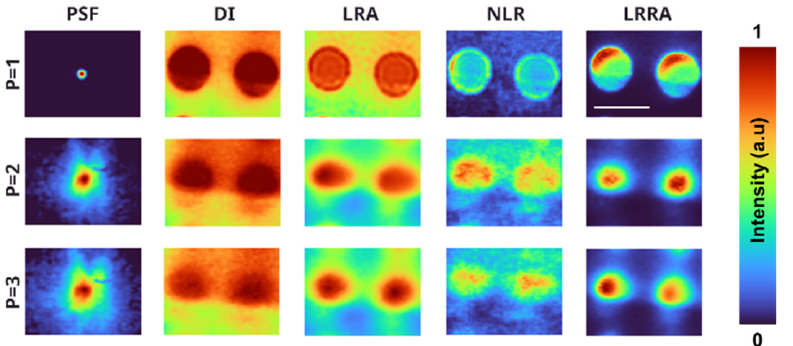
Figure 8. Images of the PSF, DI of the test object—2, reconstruction results using LRA, NLR and LRRA. The scale bar has a length of 1 mm.